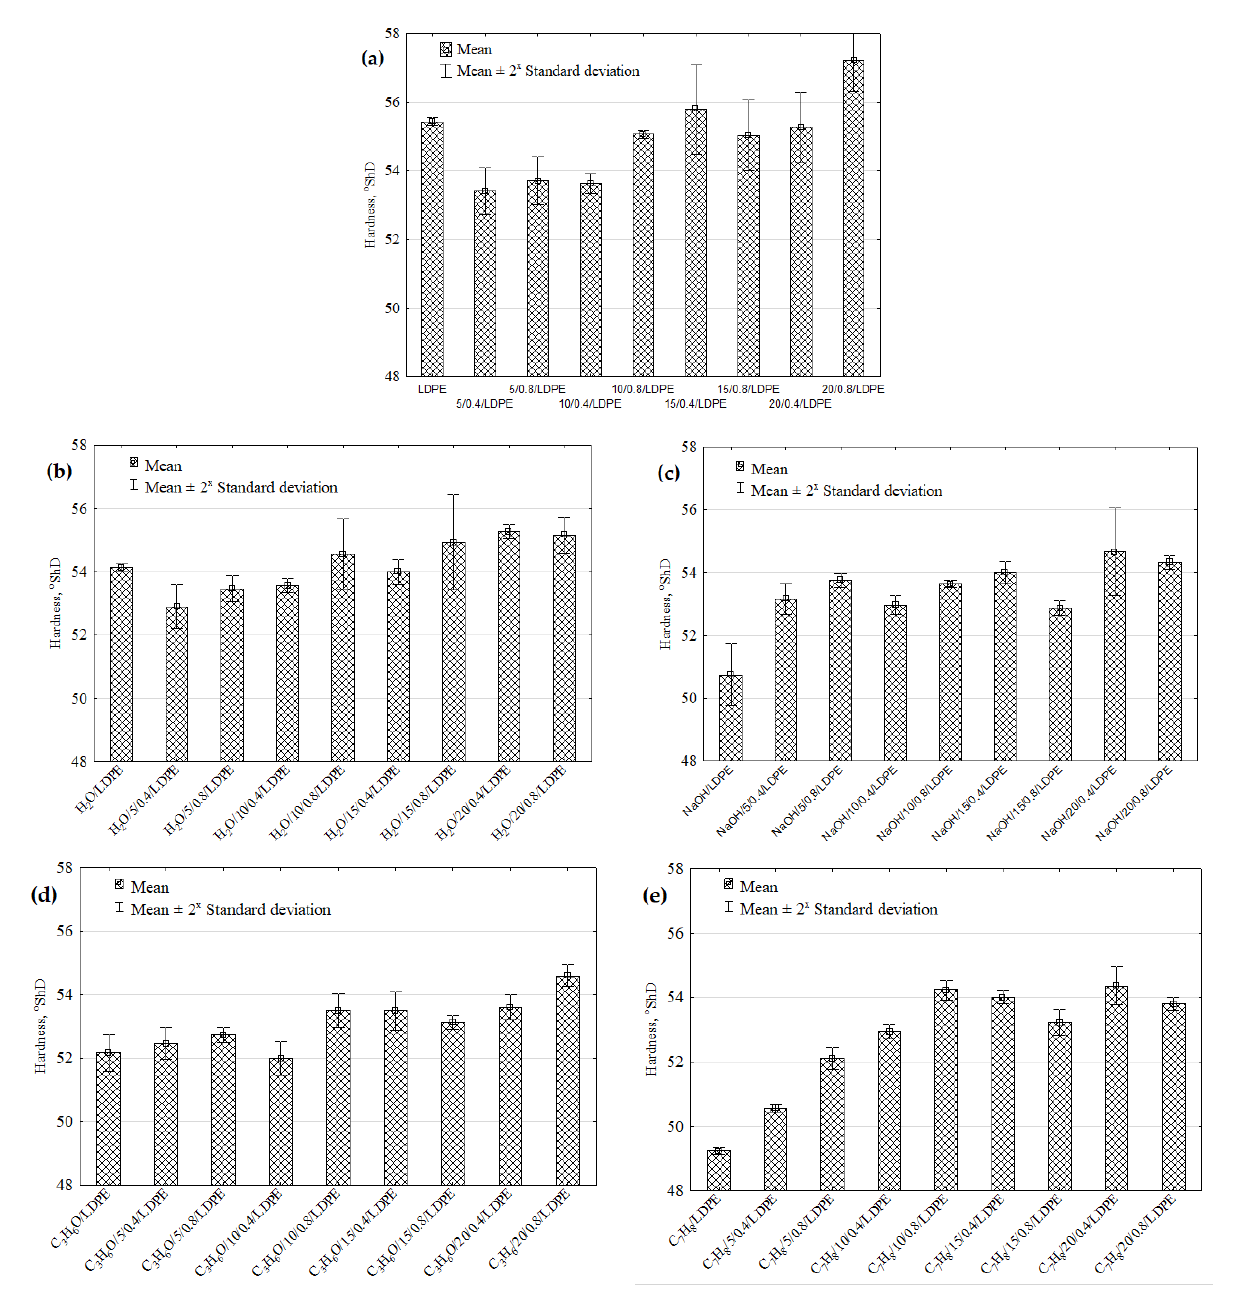
Figure 6. Hardness of pure LDPE and LDPE with a natural filler versus different solvents: ( a ) reference samples, ( b ) distilled water, ( c ) NaOH solution, ( d ) acetone, ( e ) toluene.